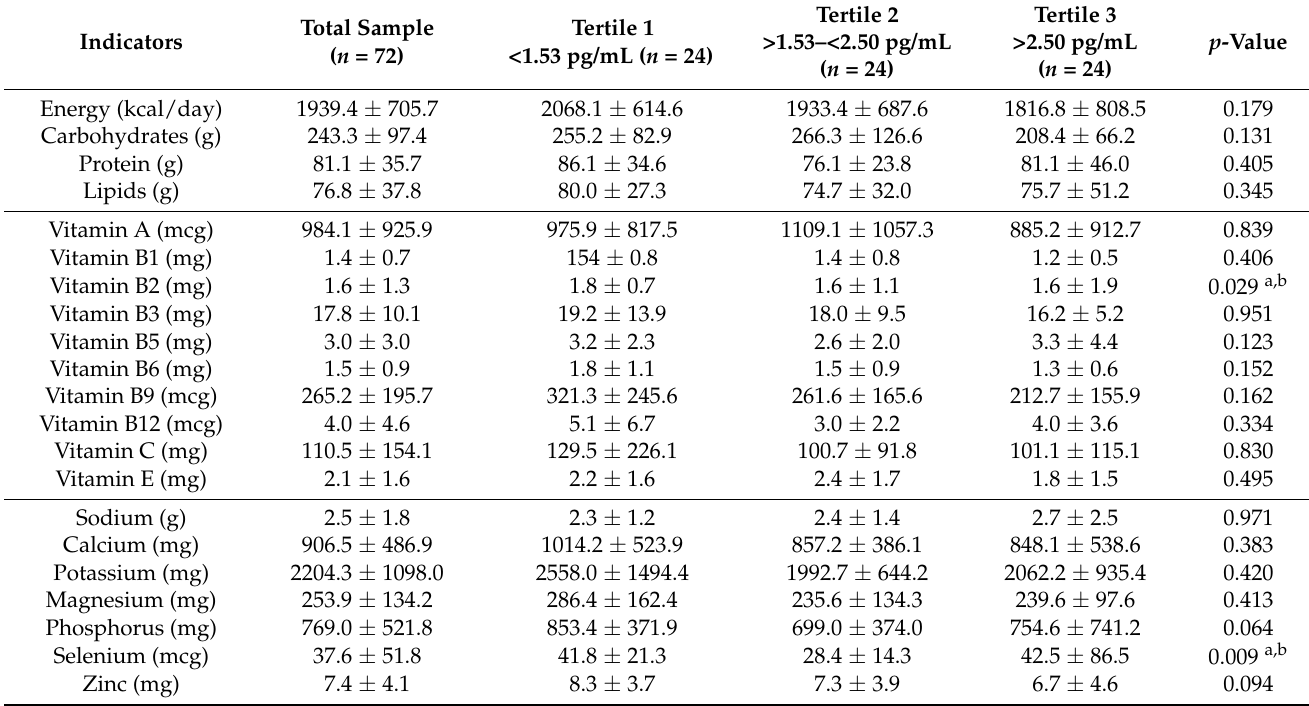
Table 6. Dietetic indicators with respect to IL-6